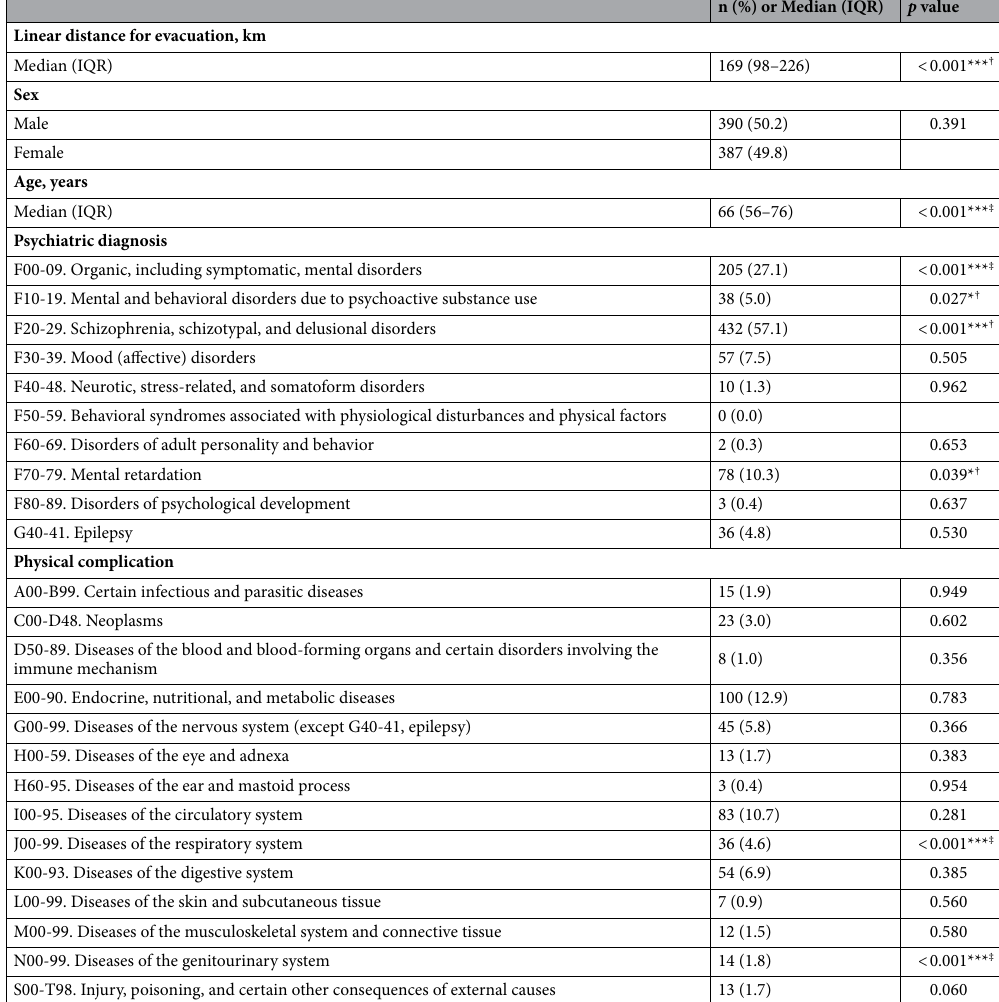
Table 2. Results of the univariable analysis for the association between mortality and basic characteristics of participants (N = 777). IQR: interquartile range. The log-rank test was adopted for the analysis. The mortality rates of participants with each psychiatric diagnosis or physical complication were compared with those of patients unaffected by any disease. * p < 0.05, ** p < 0.005, *** p < 0.001. † Factor showed a tendency toward lower mortality. ‡ Factor showed a tendency toward higher